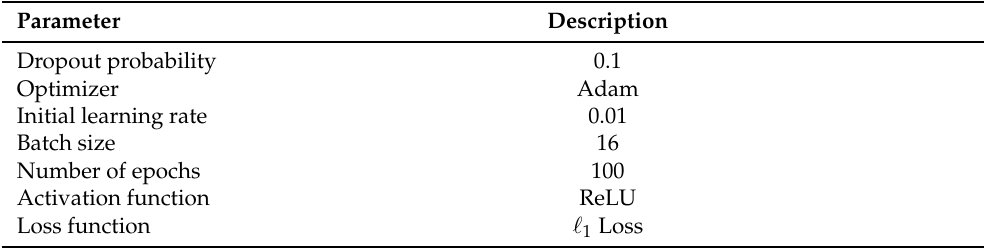
Table 2. Hyperparameters of the Proposed